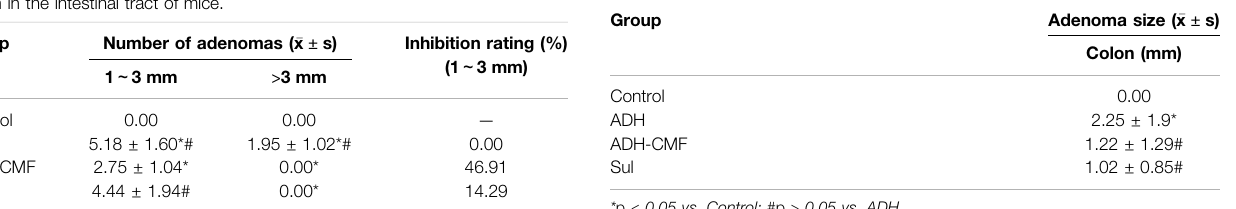
TABLE 2 | Adenoma size of colon